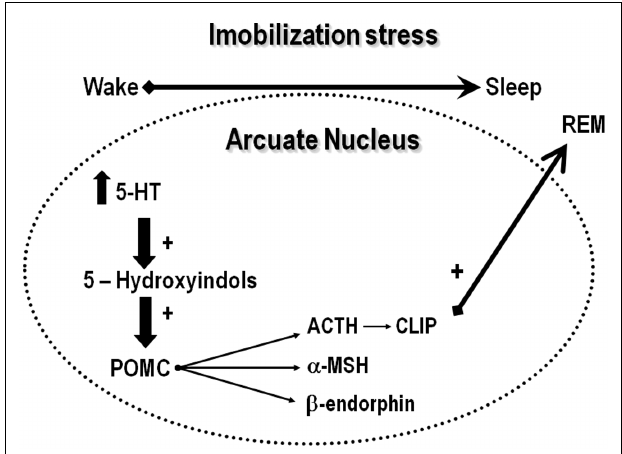
FIGURE 3 |The serotonergic hypothesis of acute stress-induced sleep rebound. According to this hypothesis, stress induces the release of serotonin, which is metabolized to 5-hydroxyindole substances that stimulates the cleavage of pro-opiomelanocortin, originating adrenocorticotropic hormone (ACTH), alpha-melanocyte stimulating hormone ( α -MSH) and β -endorphin. ACTH is metabolized originating corticotropin-like intermediate lobe peptide (CLIP), which is a major inducer of